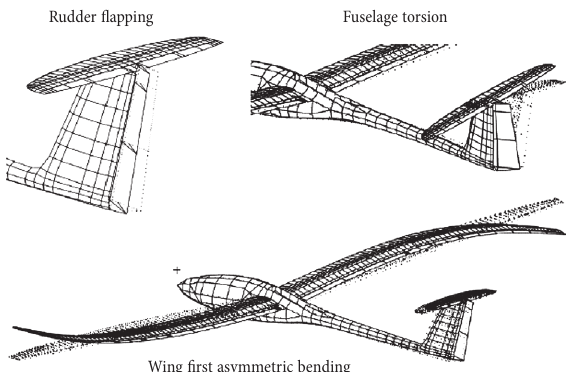
Fig. 6. Sailplane LAK-17B normal modes of